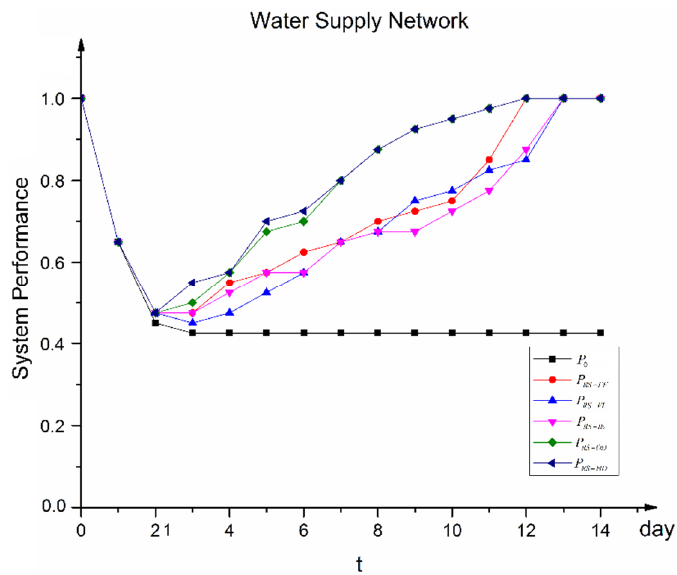
Figure 9. Performance of the example water supply network after a large flood under five response